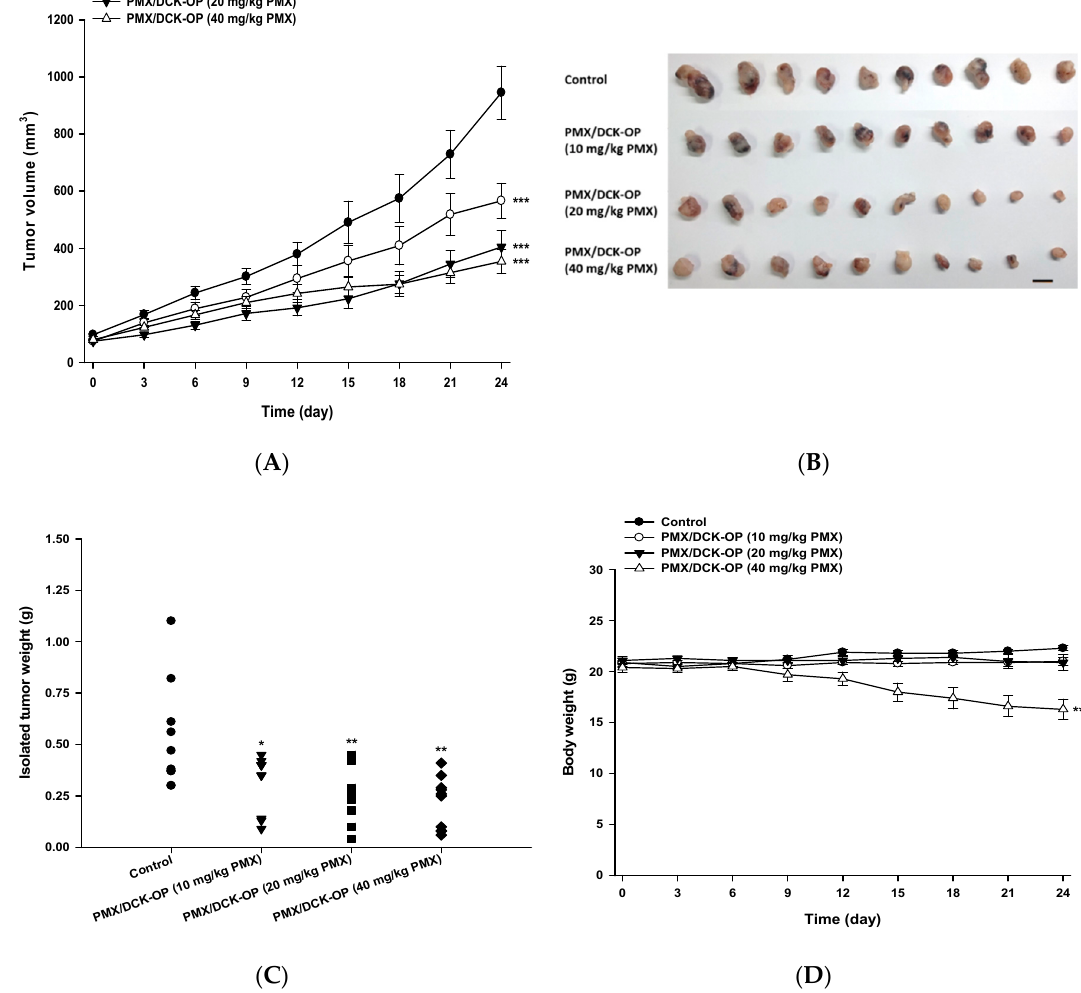
Figure 6. In vivo tumor growth inhibitory effects of PMX/DCK-OP in A549 xenografts. After tumor volume reached 50–70 mm 3 , the mice were randomized ( n = 10 mice per group) into (1) Control group, receiving saline, (2) the PMX/DCK-OP (10 mg/kg PMX) group, receiving once daily administration of 10 mg/kg PMX/DCK-OP based on PMX, (3) the PMX/DCK-OP (20 mg/kg PMX) group, receiving once daily administration of 20 mg/kg PMX/DCK-OP based on PMX, and (4) the PMX/DCK-OP (40 mg/kg) group, receiving once daily administration of 40 mg/kg PMX/DCK-OP based on PMX. ( A ) Tumor volume of different groups. ( B ) Image of isolated tumors from each group on day 24. ( C ) Tumor weight of mice on day 24. ( D ) Body weight graph of different groups. Bar means 10 mm. Data are expressed as mean ± SEM. * p < 0.05, ** p < 0.01, *** p < 0.001 compared to the control group. 3.8. In Vivo Anti-Angiogenic Effect of Oral Metronomic Chemotherapy of PMX/DCK-OP